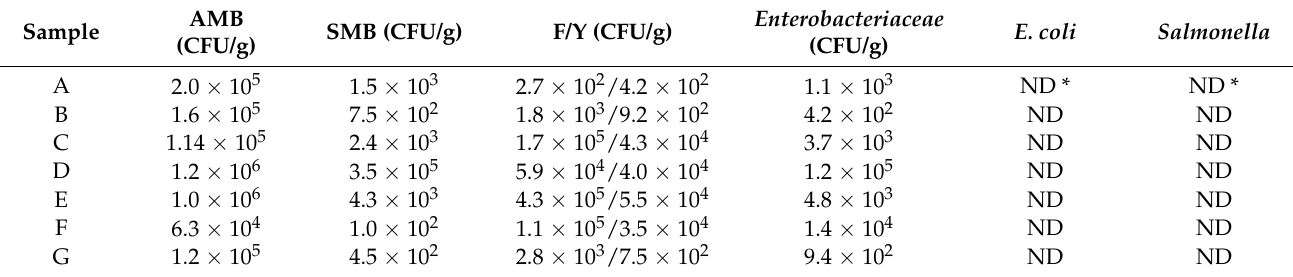
Table 1. Bacterial and fungal load in chili powder